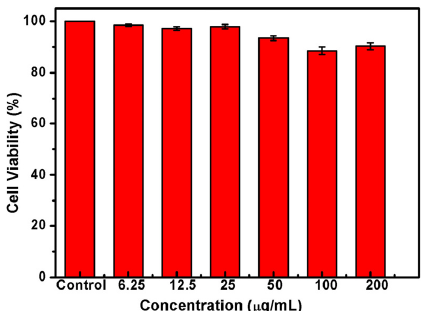
Figure 5. The N 2 adsorption/desorption isotherms and pore size distribution (inset) of Fe 3 O 4 @SiO 2 @GdVO 4 :Dy 3+ .